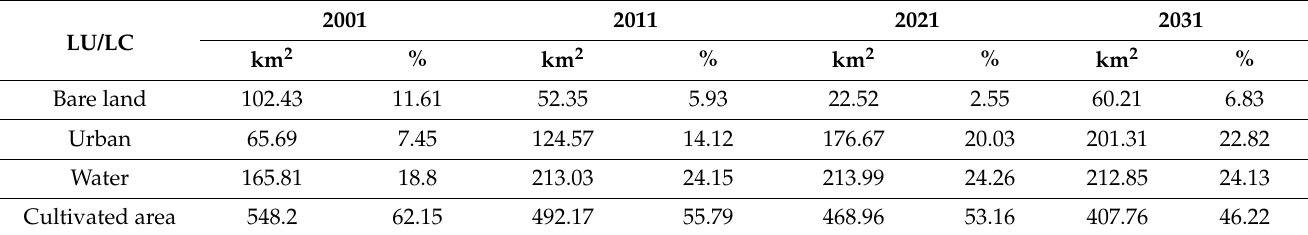
Table 4. Changes in LU/LC (km 2 ) and percentage (%) from 2001–2031.